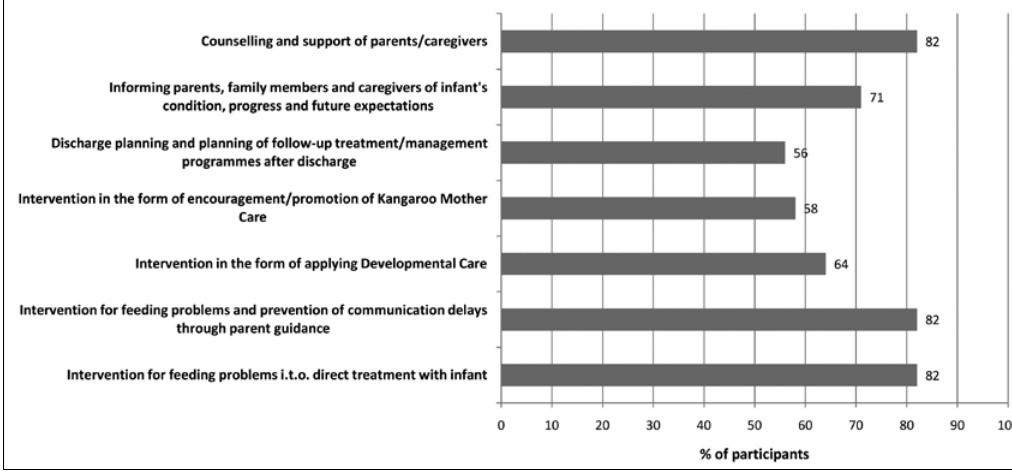
Fig. 2. Speech-language therapists’ roles in intervention specifically directed at the infant and parents/caregivers ( N =39).